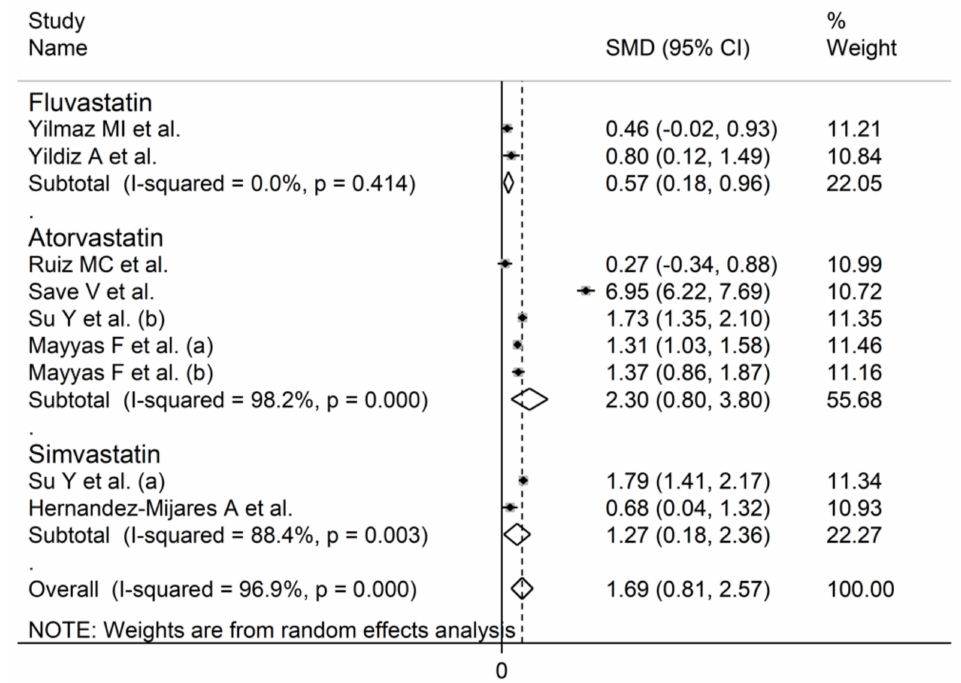
Figure 9. Forest plot of studies of individual statins on SOD